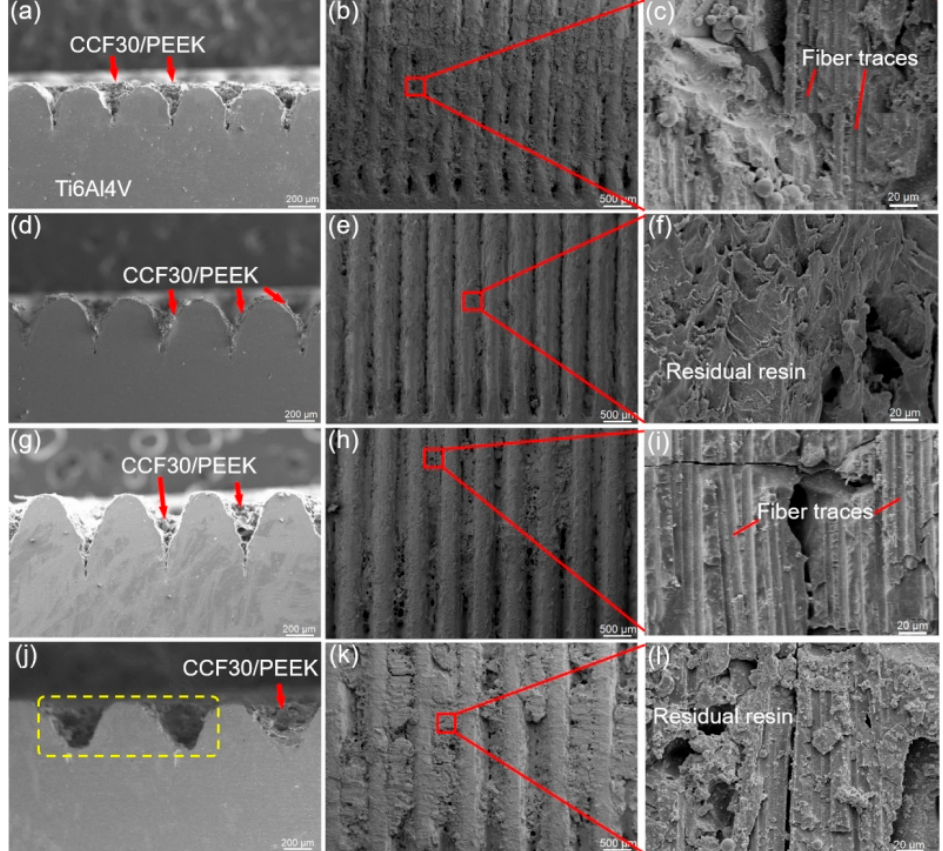
Figure 8. Fracture surface morphology of the typical CCF30/PEEK-Ti6Al4V joints after tensile tests under the condition of microgroove orientation of 90 ◦ . The microgroove width was 225 ± 15 µ m ( a – c ), 265 ± 10 µ m ( d – f ), 335 ± 10 µ m ( g – i ), and 425 ± 15 µ m ( j – l ),